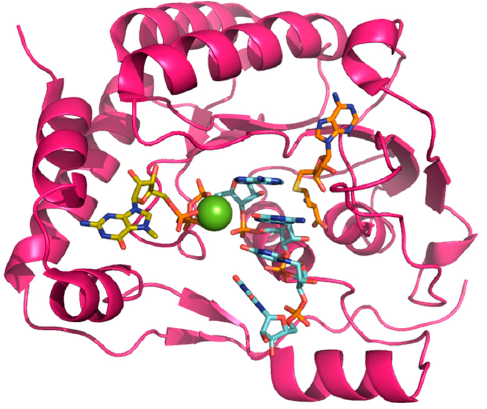
Figure 2. MTase domain structure bound to 7-methylguanosin (m7)-GpppAGUU. The MTase domain of DENV NS5 (PDB access code: 4V0Q) is shown as pink ribbons. The RNA with sequence 5’AGUU-3’ is shown as sticks and colored in light blue. The m7G and S-adenosyl-L-homocysteine (SAH) moieties are represented as sticks and colored in yellow and orange respectively.